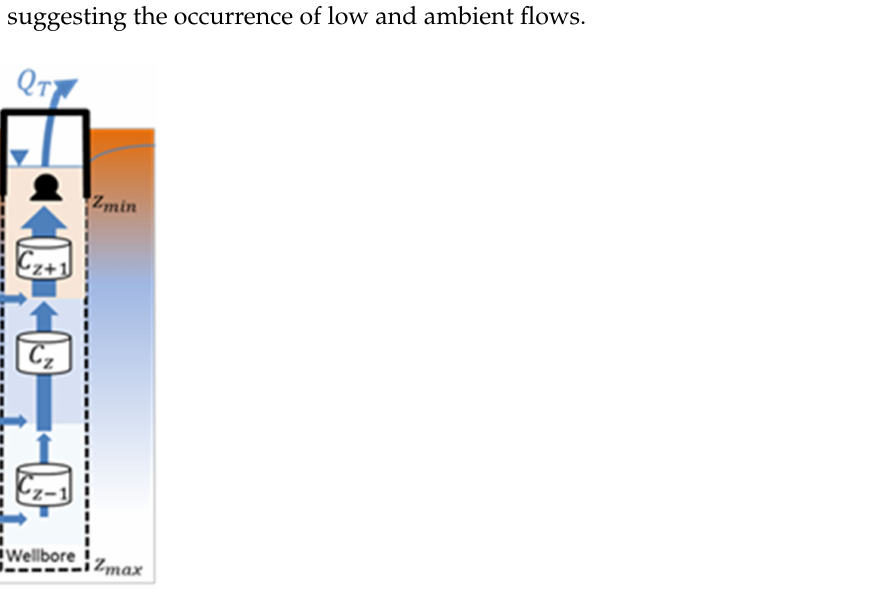
Figure 4. Representation of flow conditions and sampler placement in long screened wellbores during pumping.